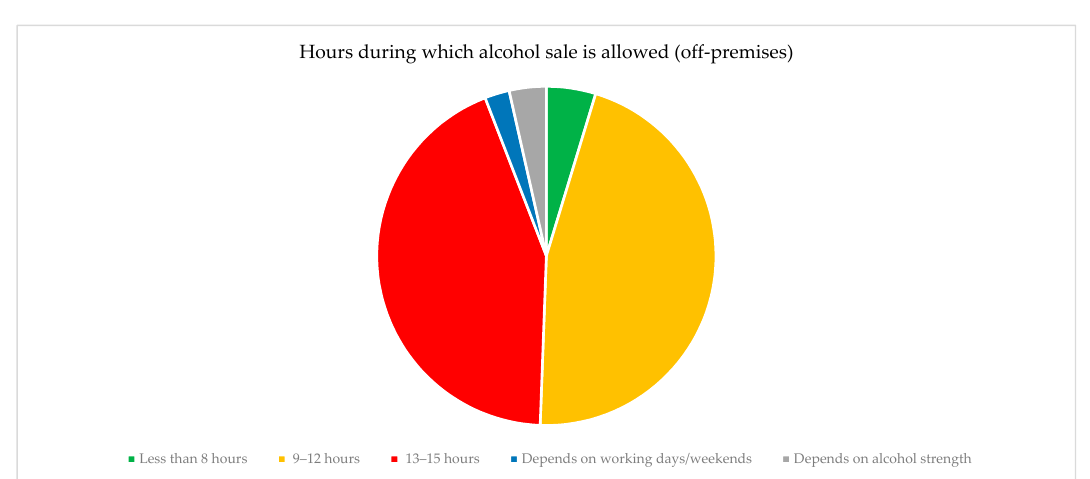
Figure A2. Regional time restrictions on hours of alcohol sales (off-premise). Source: Consultant.ru.